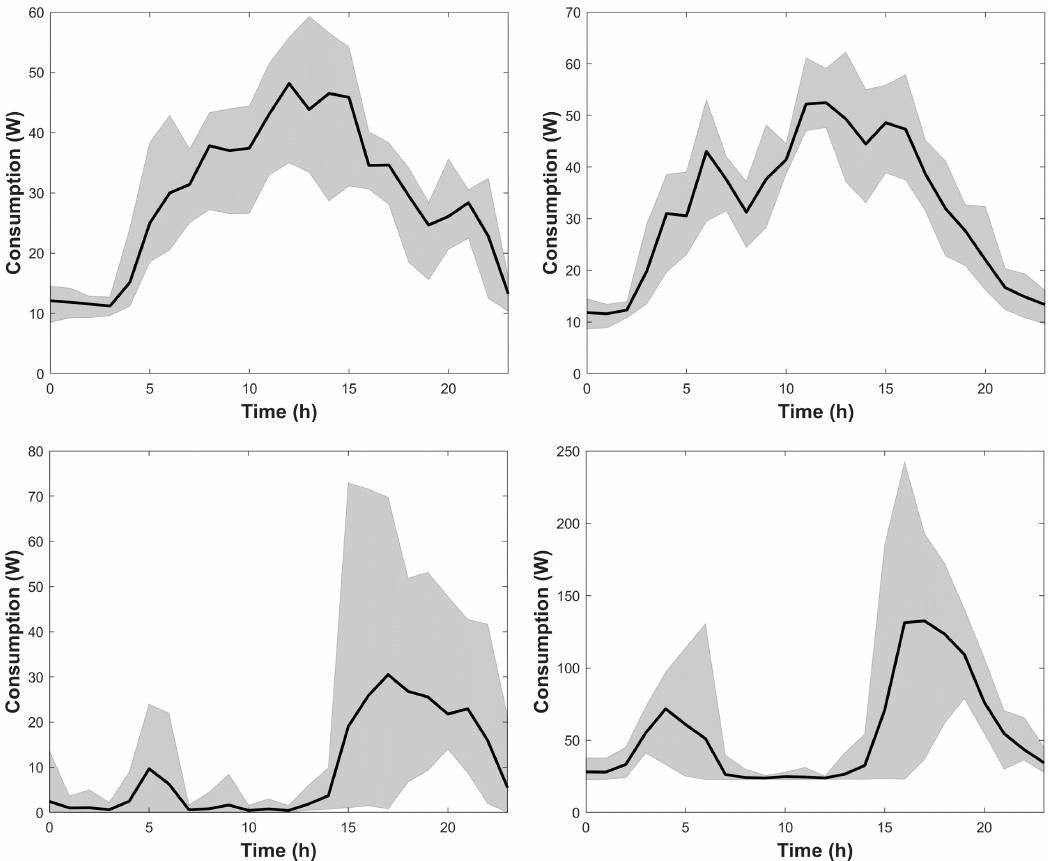
Figure 5. Hourly average annual load profiles of the elevators ( upper part ) and of the corridor lighting in the two houses ( lower part ).